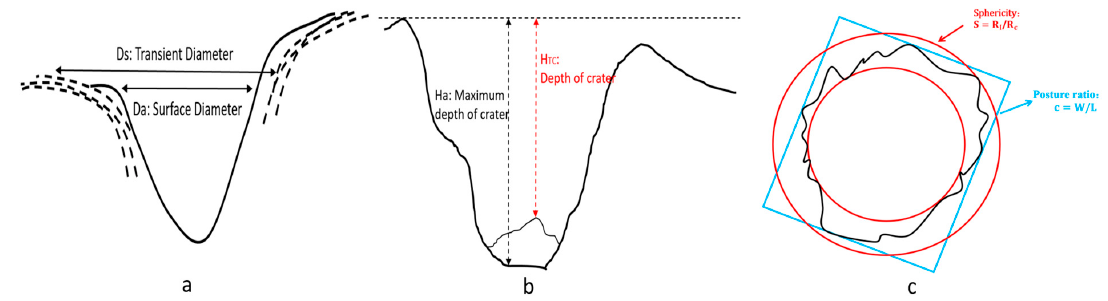
Figure 2. Schematic description of some of the indices in Table 1. ( a ) Diameter; ( b ) Depth; ( c ) Posture ratio and Sphericity.